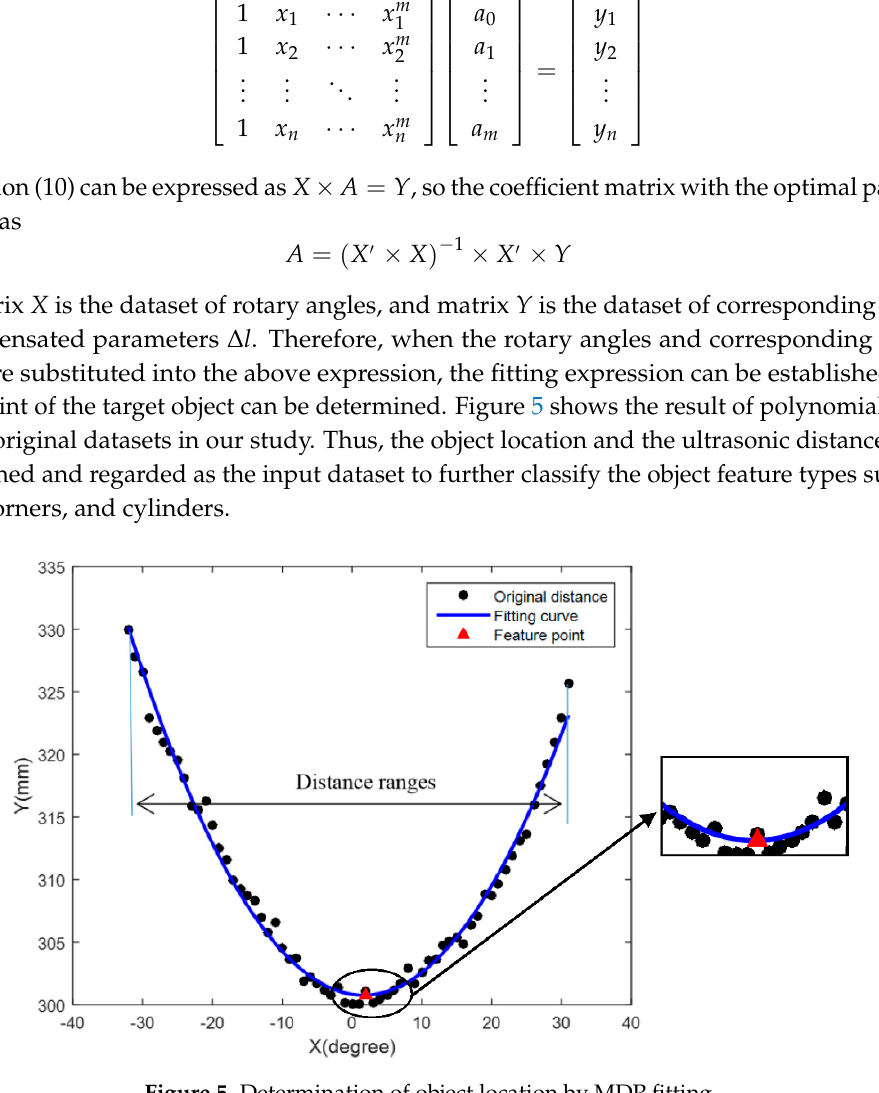
Figure 5. Determination of object location by MDP fitting.